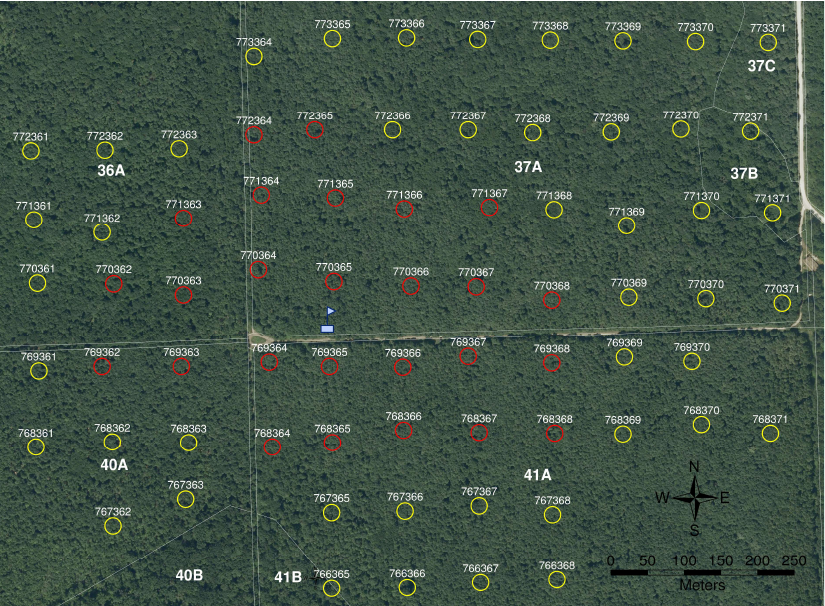
Figure A1. Aerial image of study site within ‘Jastrebarsko forest’ where circular plots have been set up; Plots with dendrometer bands are marked with a red colour; flag shows the location of EC tower; forest compartment numbers are shown in white font. The management history: Since the establishment, stand tending were performed in the 1980s, 1990s with the last tending in 2002 in the south-western forest compartment (40A). The first pre-commercial thinning was made in 1999 in the north-western compartment (36A) with the thinning intensity of 11% by volume, followed by another one of only 1.5% in early 2008 (before the start of the vegetation season). The first thinning in the south-eastern forest compartment (41A) was made in 2006 with the thinning intensity of 7% by volume, followed by a thinning made in 2007 in the north-eastern compartment (37A) with the thinning intensity of 9% by volume. During the vegetation seasons 2008 until 2017 (i.e., the period of this study) there was no further thinning or harvesting activities in the above mentioned forest stands.